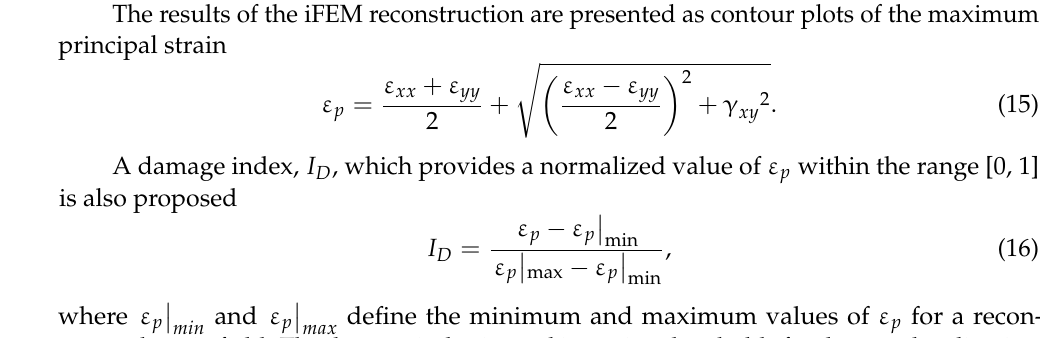
Figure 3. Sensor configuration of the benchmark inverse Finite Element Method (iFEM) model: ( a ) strain rosette grid (each point represents a strain rosette and the sensors divide the plate into nine square cells), and ( b ) magnified view of boundary elements with a maximum of five, and a minimum of three rosettes per element.